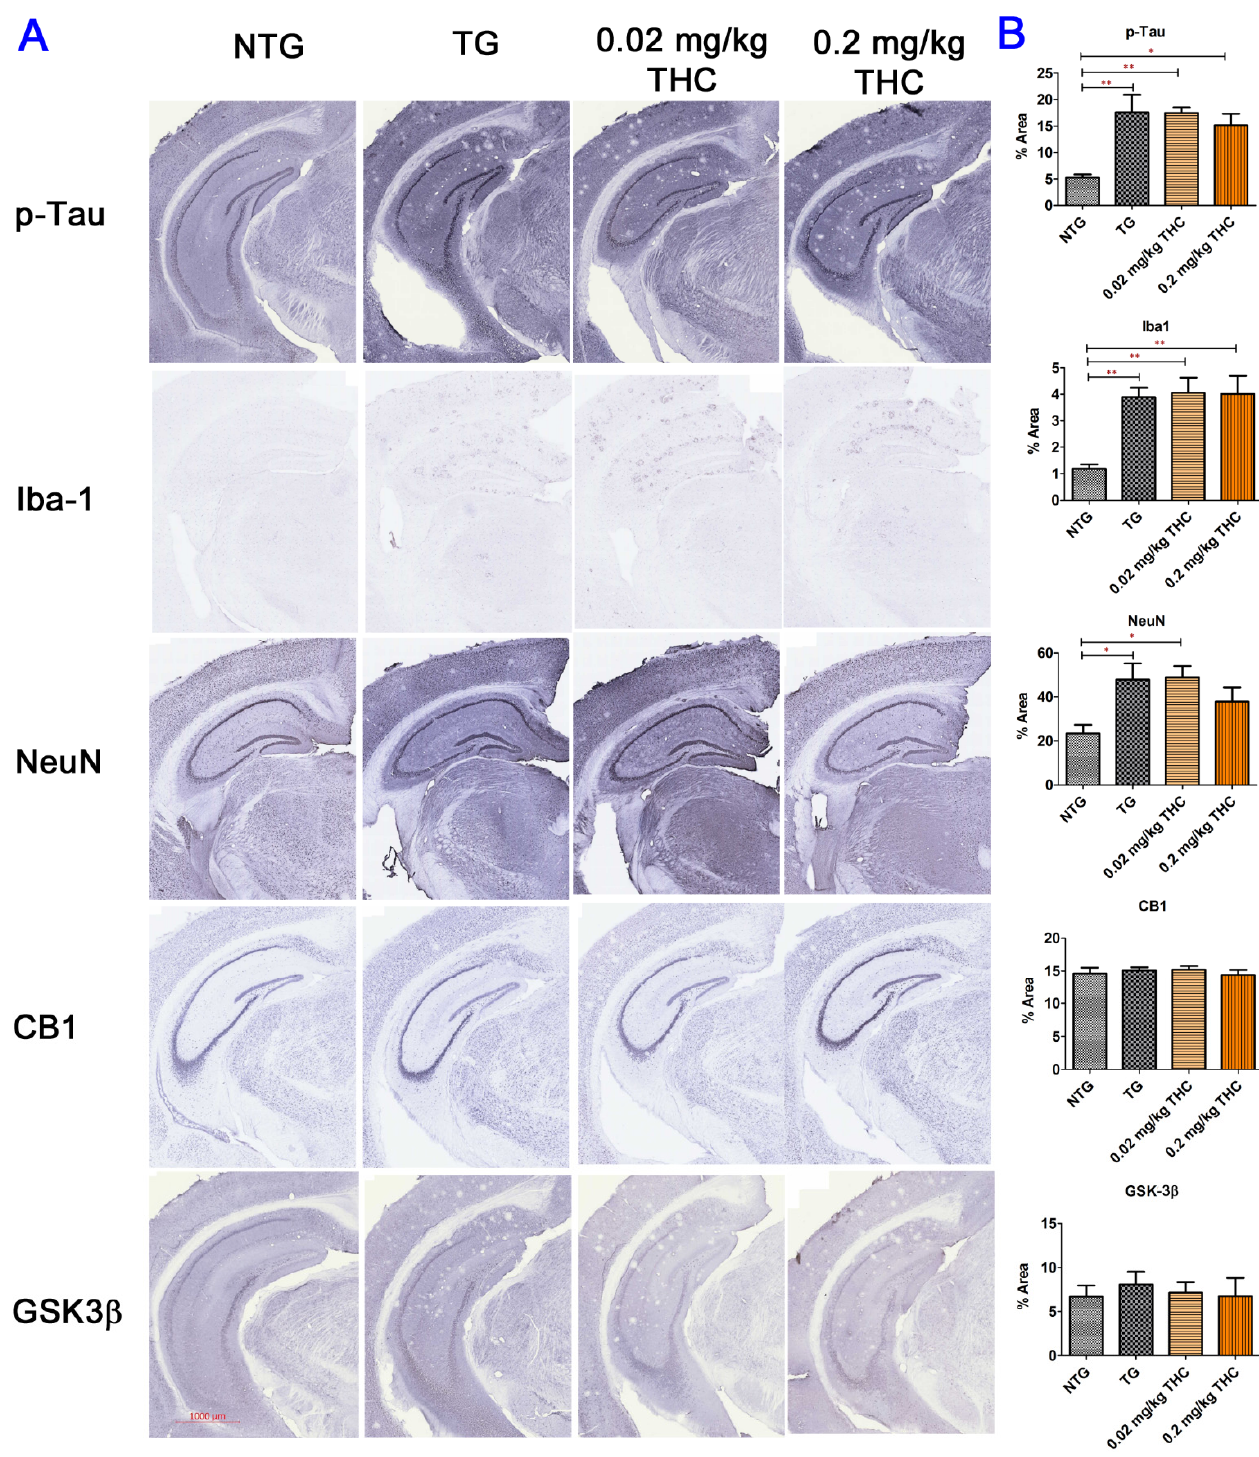
Figure 8. Immunohistochemical (IHC) analysis of molecular markers associated with the neuropathologic change in AD. ( A ) Representative IHC images for p-Tau, Iba-1, NeuN, CB1, and GSK3 β in brain sections. ( B ) Quantification of IHC staining of for p-Tau, Iba-1, NeuN, CB1, and GSK3 β in brain sections. No statistically significant difference in the expression of phospho-Tau, Iba1, CB1, and GSK-3 β and the NeuN area was observed between the vehicle and THC treatment in APP/PS1 mice, suggesting the limited effect of THC on reversing the neuropathologic change in AD. Data are expressed as mean ± SD ( N = 7 for the control NTG group, N = 6 for the control TG and 0.2 mg/kg THC groups, and N = 8 for the 0.02 mg/kg THC group). SD is denoted by the error bars. * p < 0.05 and ** p < 0.01 compared between the control NTG mice, control APP/PS1 mice, and APP/PS1 mice